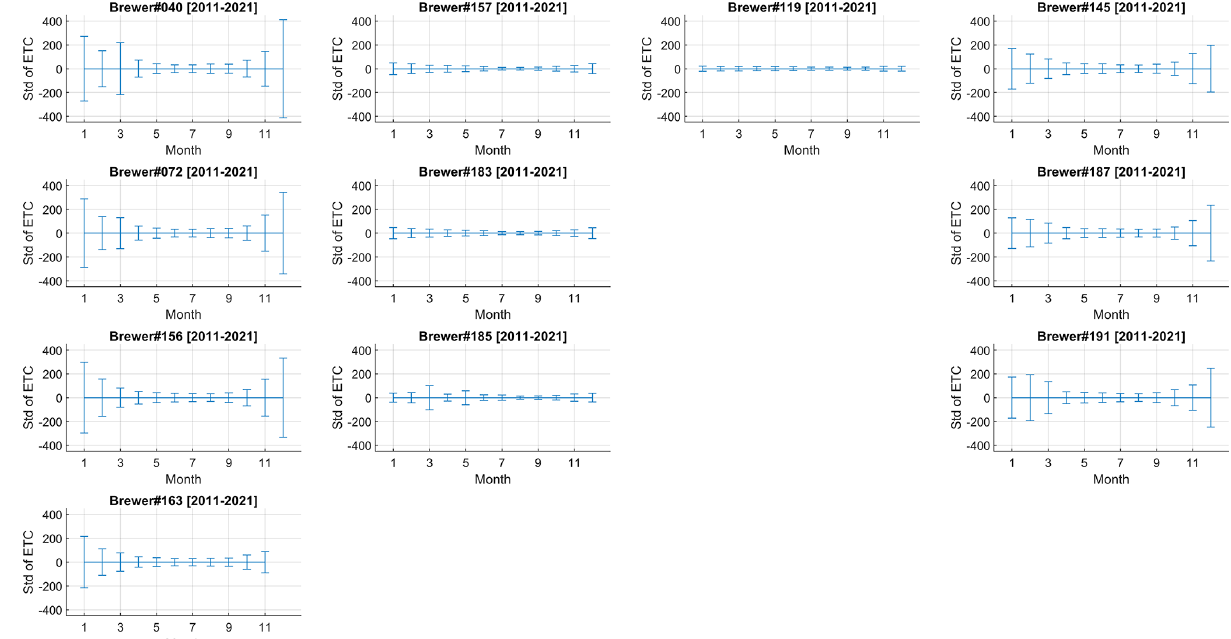
Figure B1. Monthly standard deviations of individual ETCs for all Brewer instruments included. Error bars represent the 1 σ of individual ETCs for the month. The instrument serial number and its observation period are shown on the title of each panel.